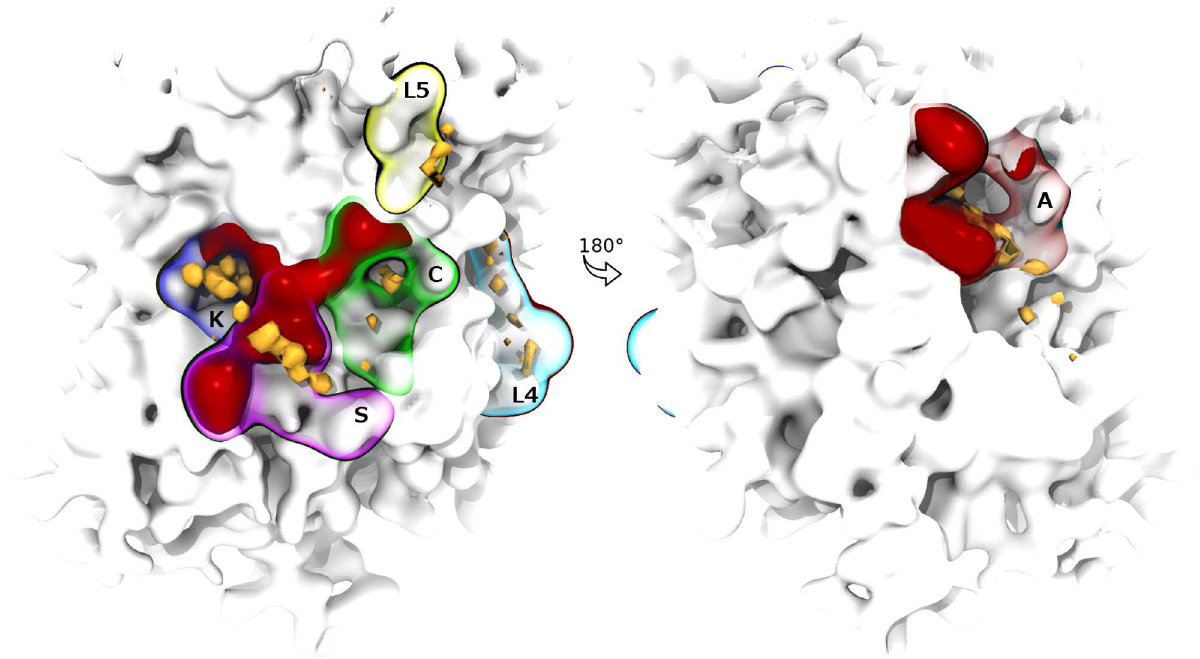
Fig 3. Overview of the cholesterol interaction sites mapped on the SERT’s transmembrane surface. The sites are drawn as differently colored contoured surfaces, while corresponding outliers are shown in red. Cholesterol density is normalized to the averagebulk value (isovalueof 1) and displayedas yellow surfaces at a contour level of 60 (left) and 40 (right) hits/ Å 3 . See Fig 2 for outliers’ identity.